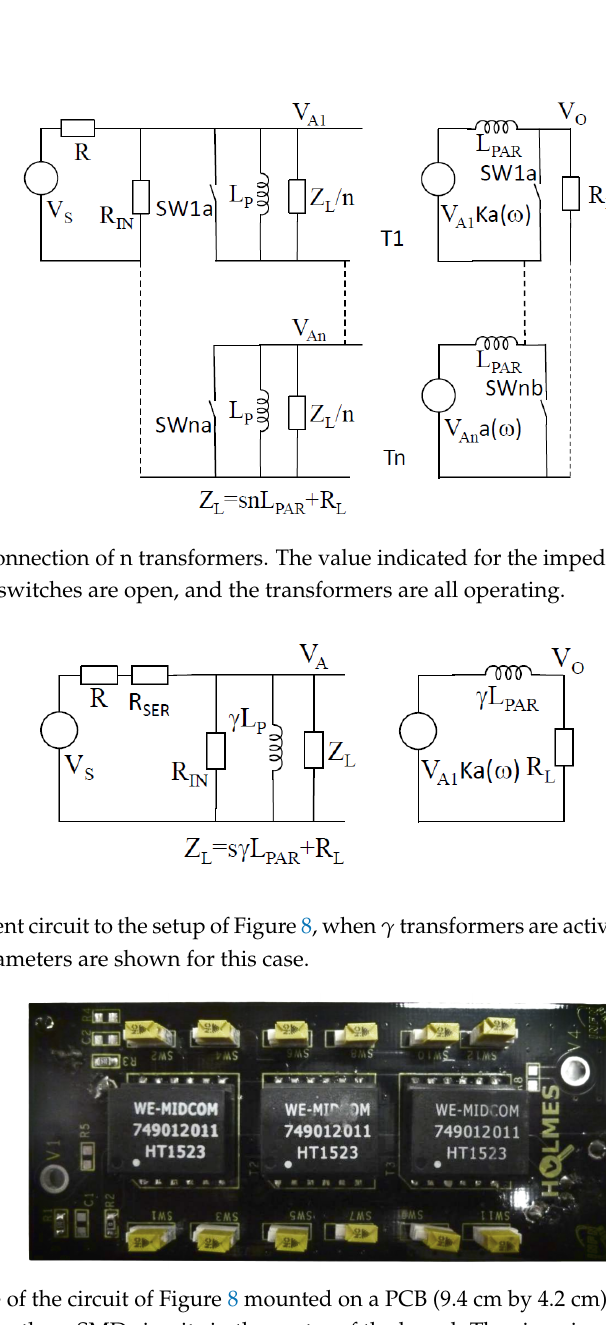
Figure 10. Picture of the circuit of Figure 8 mounted on a PCB (9.4 cm by 4.2 cm). The six transformers are contained in the three SMD circuits in the center of the board. The six pairs of yellow switches are SW1, ...,